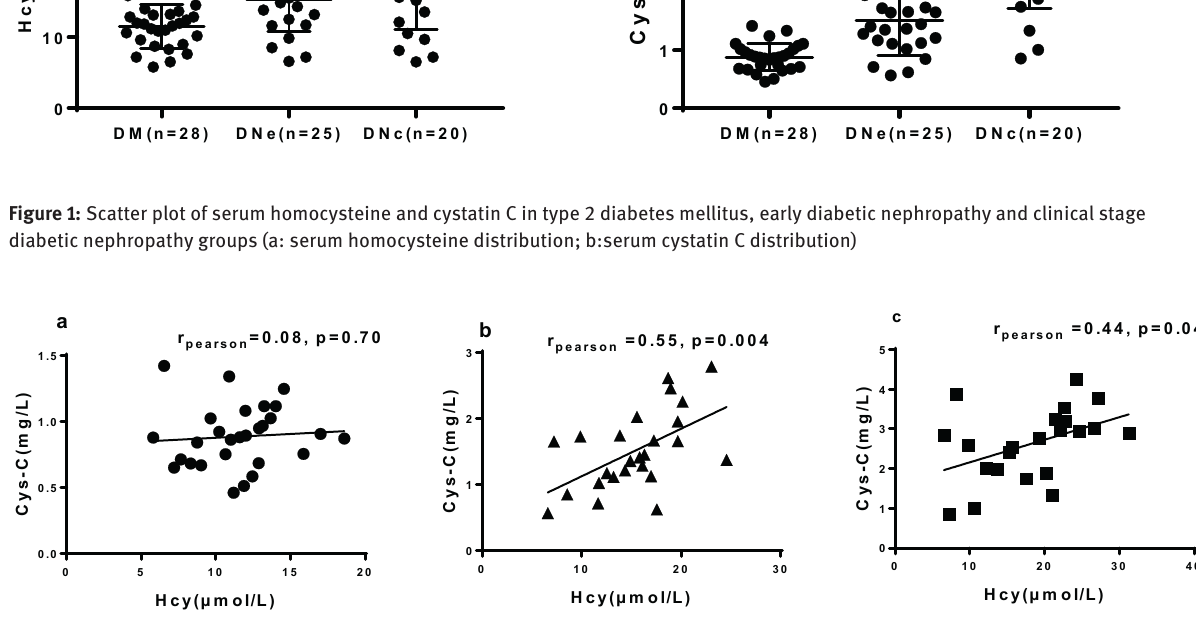
Figure 2: Pearson correlation between serological homocysteine and cystatin C in type 2 diabetes mellitus, early diabetic nephropathy and clinical stage diabetic nephropathy (a: homocysteine and cystatin C in type 2 diabetes mellitus group; b: homocysteine and cystatin C correlation in early diabetic nephropathy group; c: homocysteine and cystatin C correlation in clinical stage diabetic nephropathy